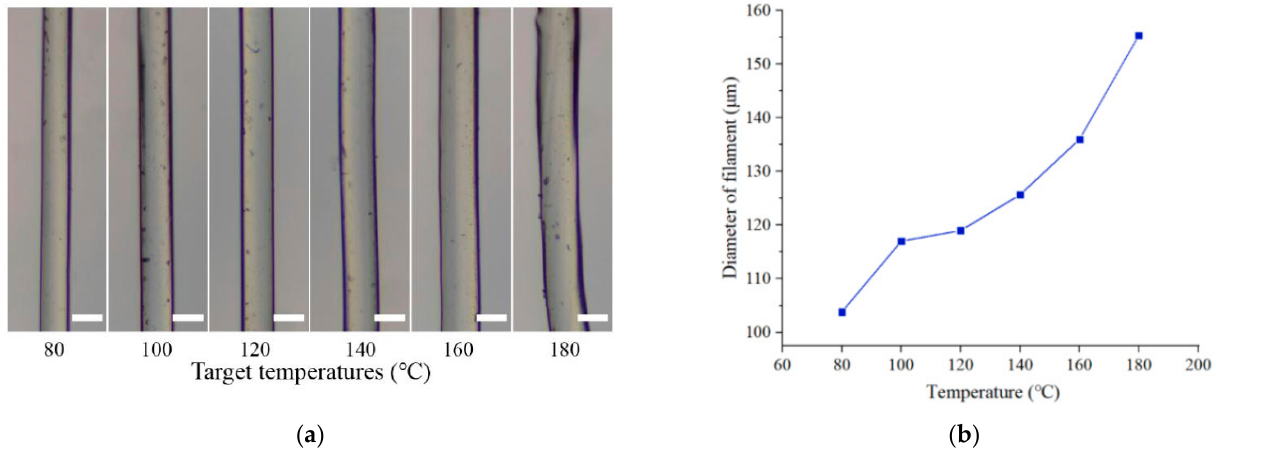
Figure 9. ( a ) Micrographs of printed PLCL filaments with varying temperatures, ( b ) diameters of printed filaments. Scale bar: 100 μ m.